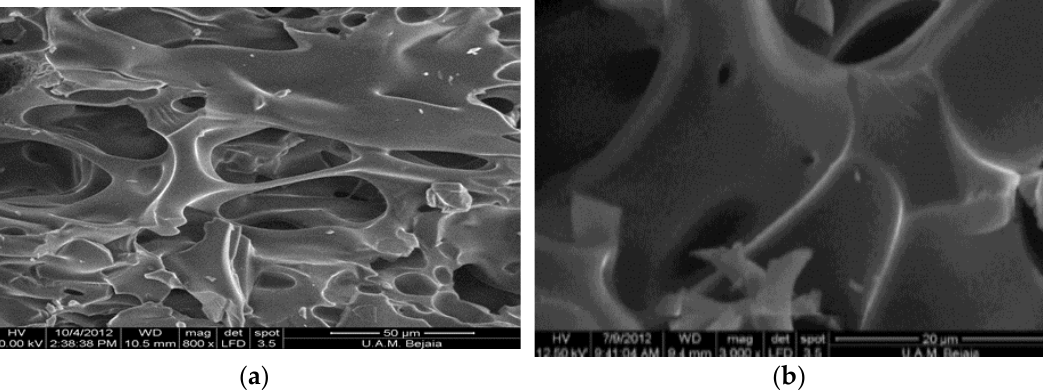
Figure 3. Feature (SEM) of ß-cyclodextrin polymer at ( a ) 800 × magnification and ( b ) 3000 × magnification.